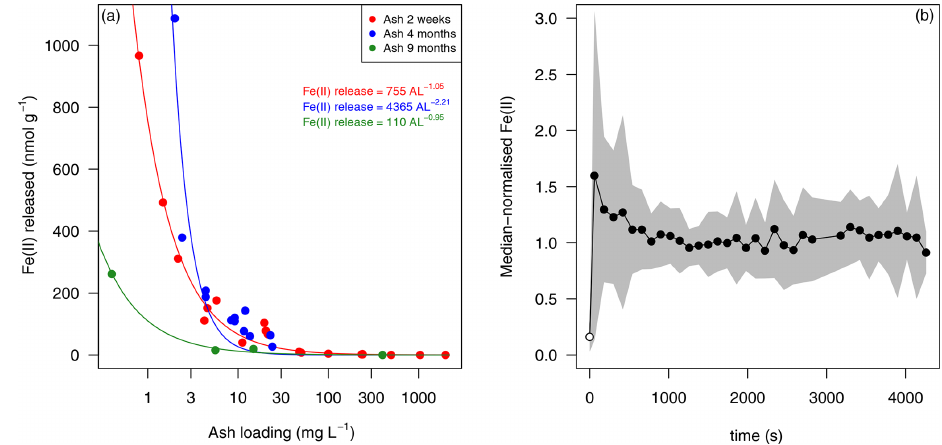
Figure 7. Fe(II) release from Calbuco ash into seawater. (a) Mean Fe(II) released into South Atlantic seawater over a 30min leach at 5–7 ◦ C. The same batch of Calbuco ash was subsampled and used to conduct experiments on three occasions after the 2015 eruption (2 weeks, 4 months and 9 months since ash collection). The lines are power law fits, with the associated equations shown in the legend. (b) The three time series of Fe(II) concentrations following ash addition are considered collectively by normalising the measured concentrations, such that 1.0 represents the median Fe(II) concentration measured in each experiment. All experiments were conducted for at least 30min, those conducted with 4- and 9-month-old ash were extended for 1h. The black line shows the mean response over 34 leach experiments with varying ash loading, and the shaded area shows ± 1 standard deviation. The initial Fe(II) concentration (pre-ash addition at 0s) in all cases was below detection; thus, the detection limit is plotted at 0s (open circle). Source data are provided in the Supplement (Table